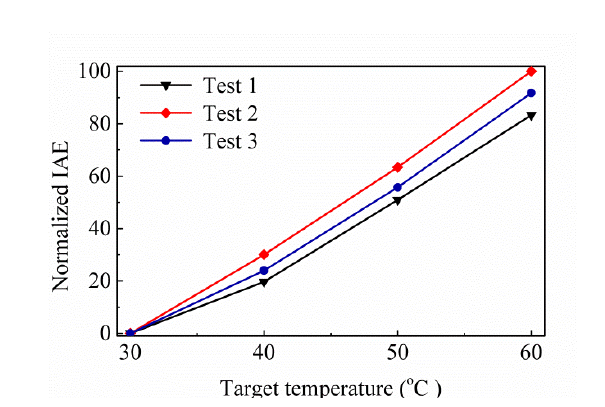
Figure 8. SA-SRHA SEM image of the CMOS compatible thermopile.